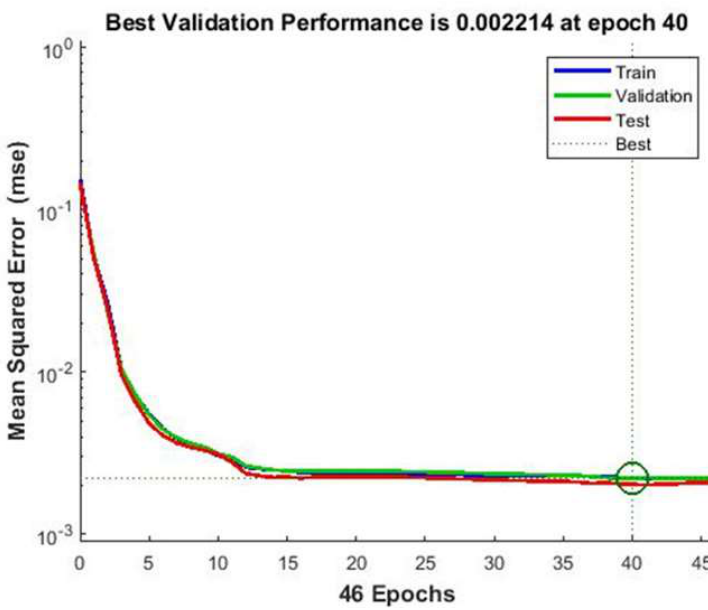
Figure 9. The MSE results of ANN together with the number of epochs.